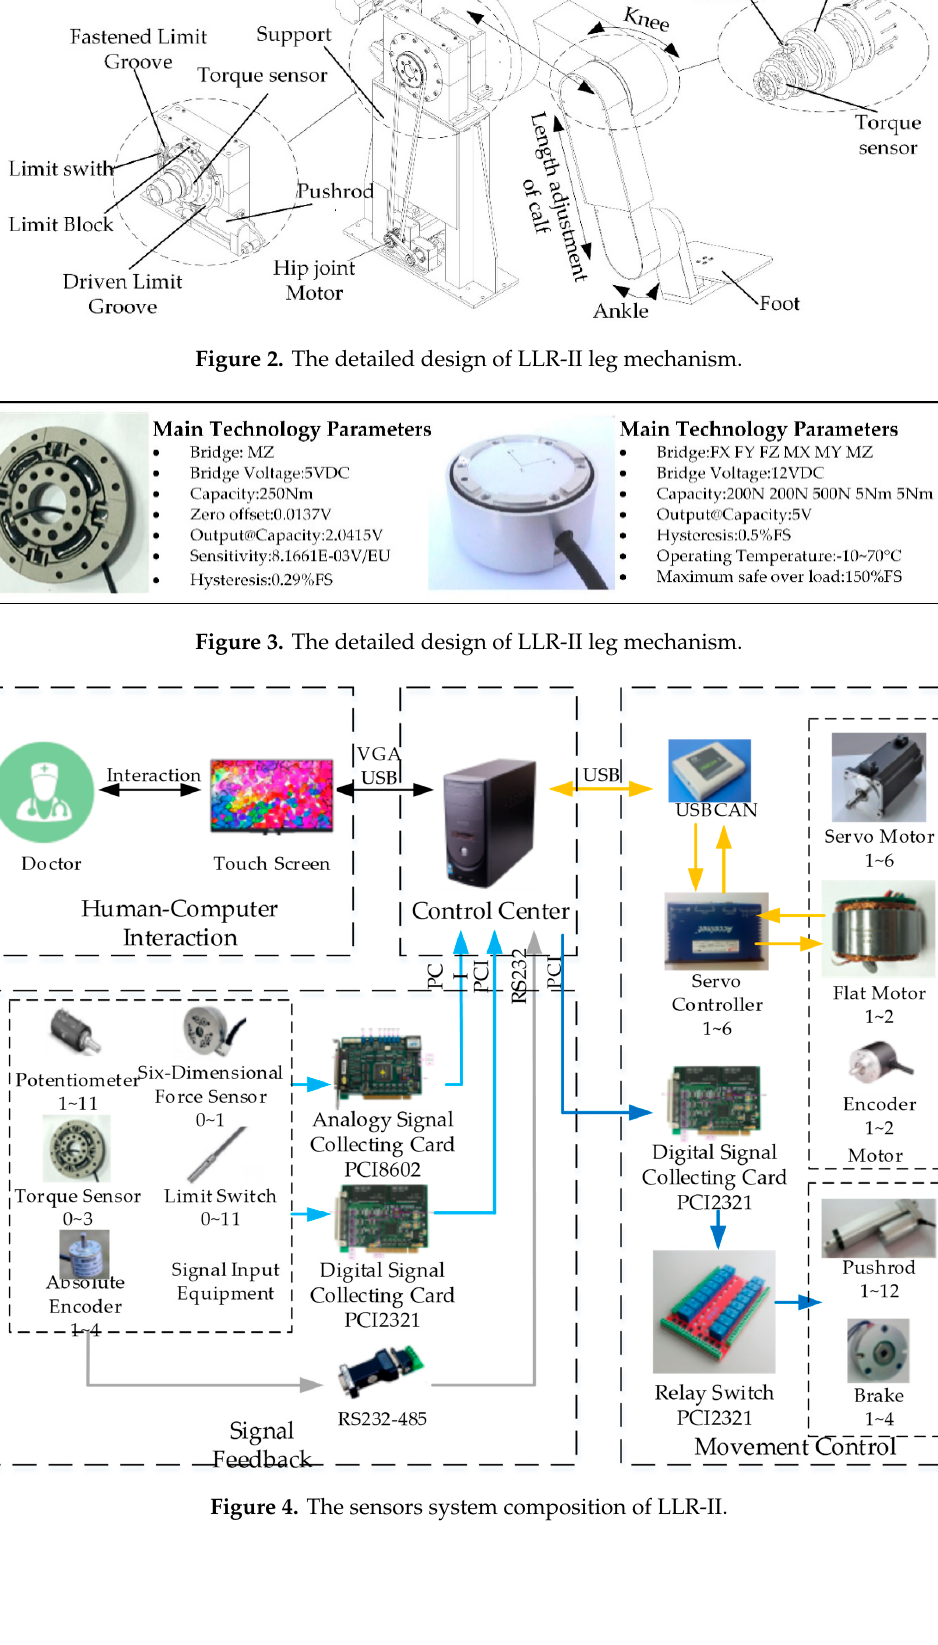
Figure 4. The sensors system composition of LLR-II.